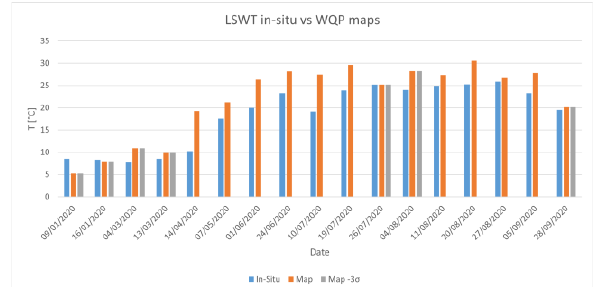
Figure 2 . Comparison in-situ measurements and SIMILE temperature maps estimates, before (orange) and after (grey) outlier rejection